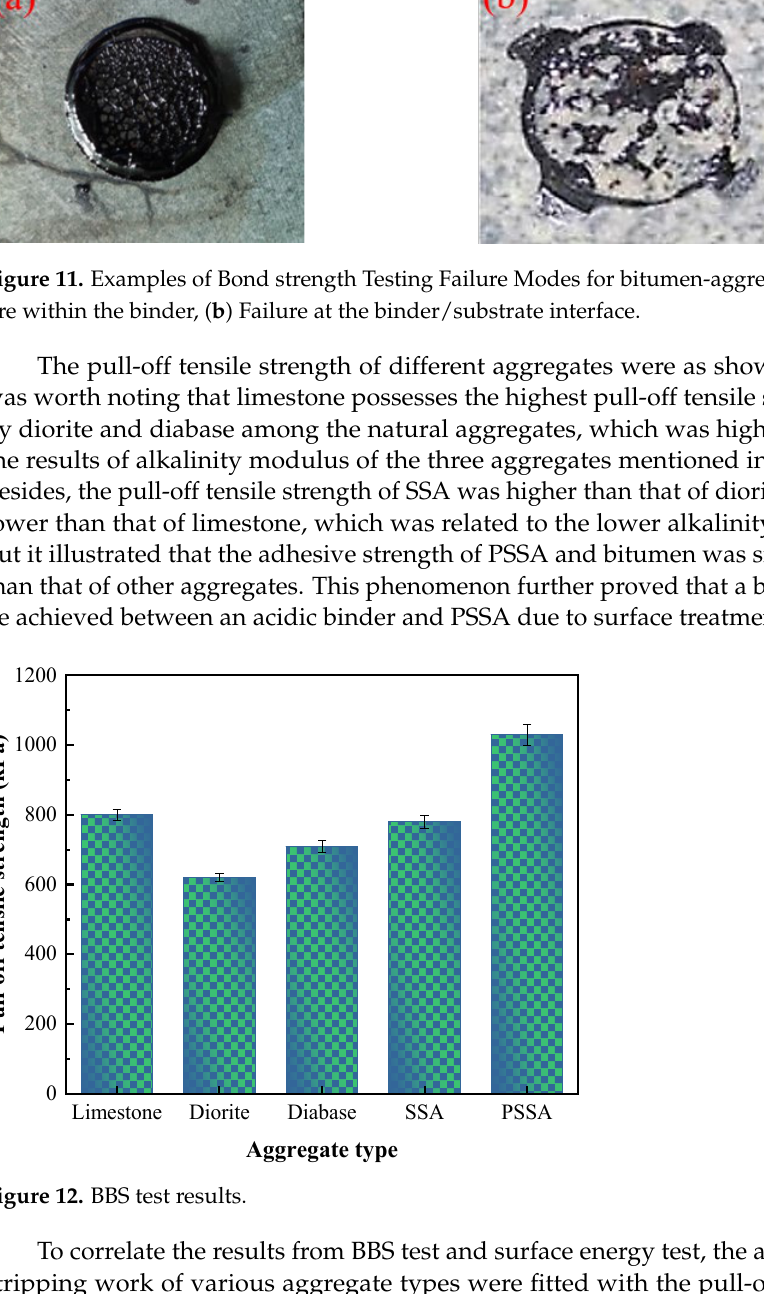
Figure 13. Fitting curves of drawing strength with adhesion work and stripping work. 3.6. Pavement Performance of Asphalt Mixture 3.6.1. Standard Marshall Test The optimal bitumen content of HMA-L, HMA-SSA and HMA-PSSA mixtures were obtained by the curve of bitumen-aggregate ratio and various volumetric and mechanical indices of the mixture (Figure 14) based on the standard Marshall tests. The values of bi- tumen-aggregate ratio correspond to the maximum gross volume relative density,